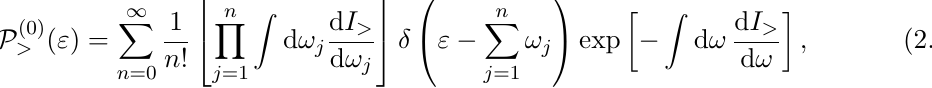
. The dotted line shows the region ω ∗ s